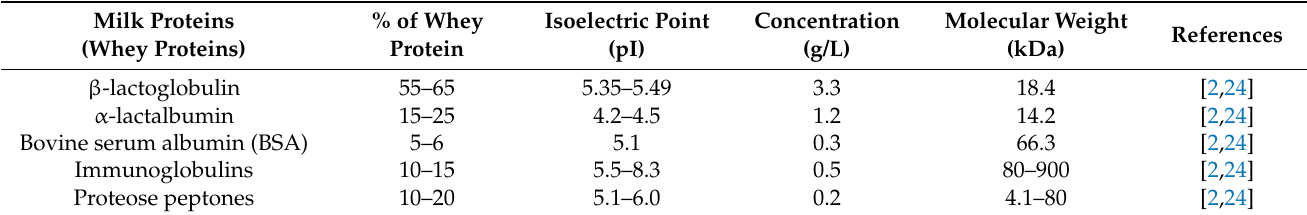
Table 2. Physical properties, molecular weight, and concentration of whey proteins in milk. Milk Proteins (Whey